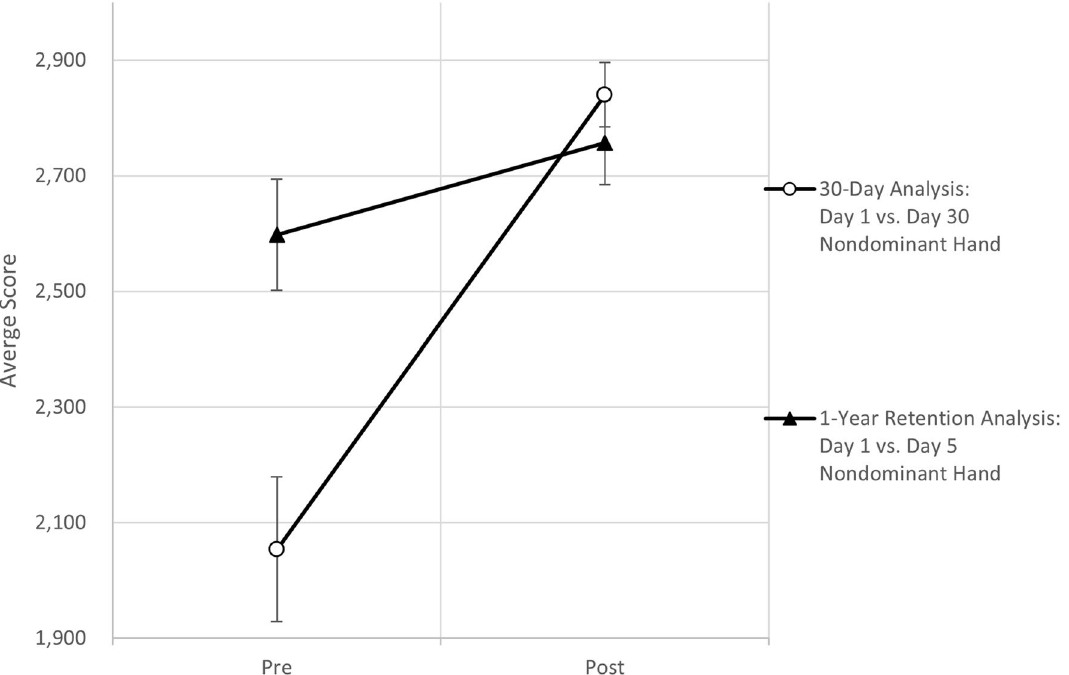
Figure 3. Mean values and standard errors for nondominant hand on day 1 versus day 30 and one year later on day 1 versus day